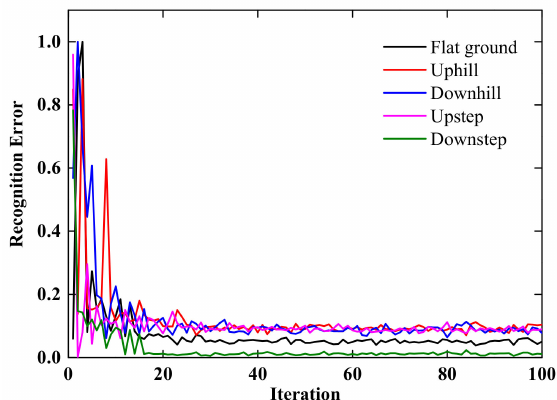
Figure 14. Training curves of the BP neural network for 5 gait types.